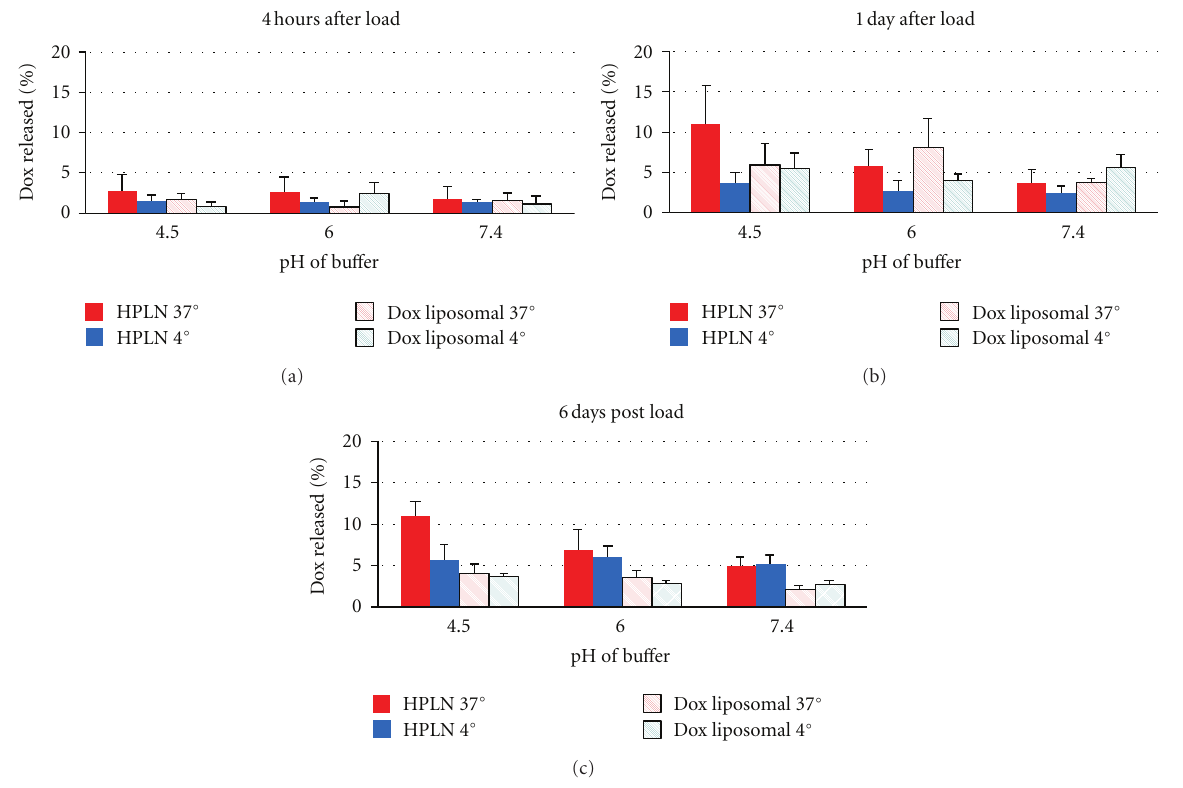
Figure 7: Containment of doxorubicin over time in drug-loaded liposomal vehicles. Containment studies of loaded HPLNs versus conventional PEG-liposomes showed that leakage increased significantly with time ( P < 0 . 0001), with geometric means at 4 hours, 1 day, and 6 days being, respectively, 0.9%, 4.6%, and 3.1% for conventional doxorubicin-loaded PEG-liposomes and 1.2%, 3.2%, and 5.9% for HPLN. There were no significant di ff erences between the vehicles or the e ff ects of pH or temperature that could be detected at 4 hours or 1 day. However, at 6 days HPLN had 1.9-fold greater overall leakage than DOX ( P < 0 . 001; 95% C.I. 1.6- to 2.4-fold). Lowering pH from 7.4 to 4.5 increased leakage by a factor of 1.5 ( P = 0 . 01; 95% C.I. 1.1- to 2.1-fold) with enhanced leakage at 37 degrees compared to 4 degrees ( P = 0 .